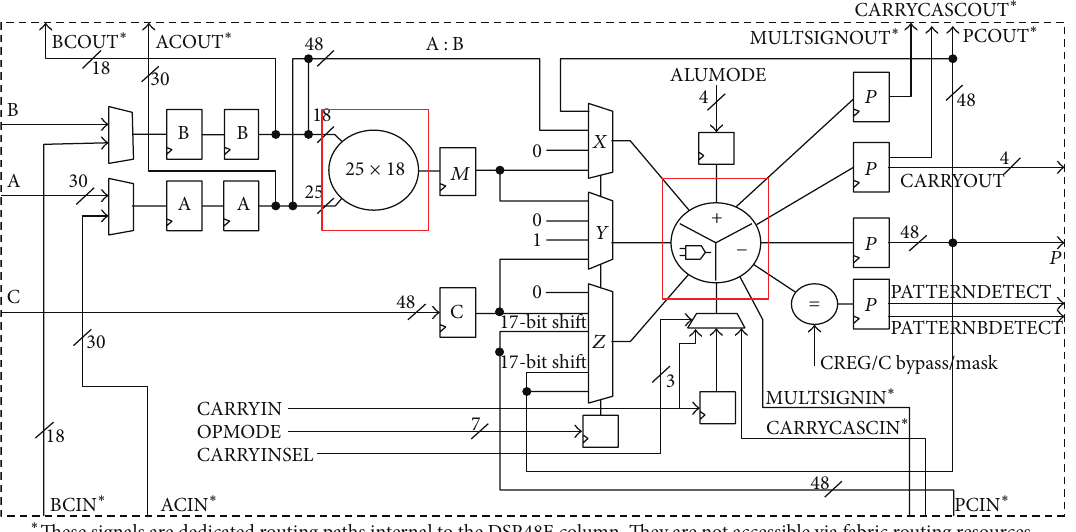
Figure 3: DSP48E1 architecture in Xilinx Virtex-5 [19].